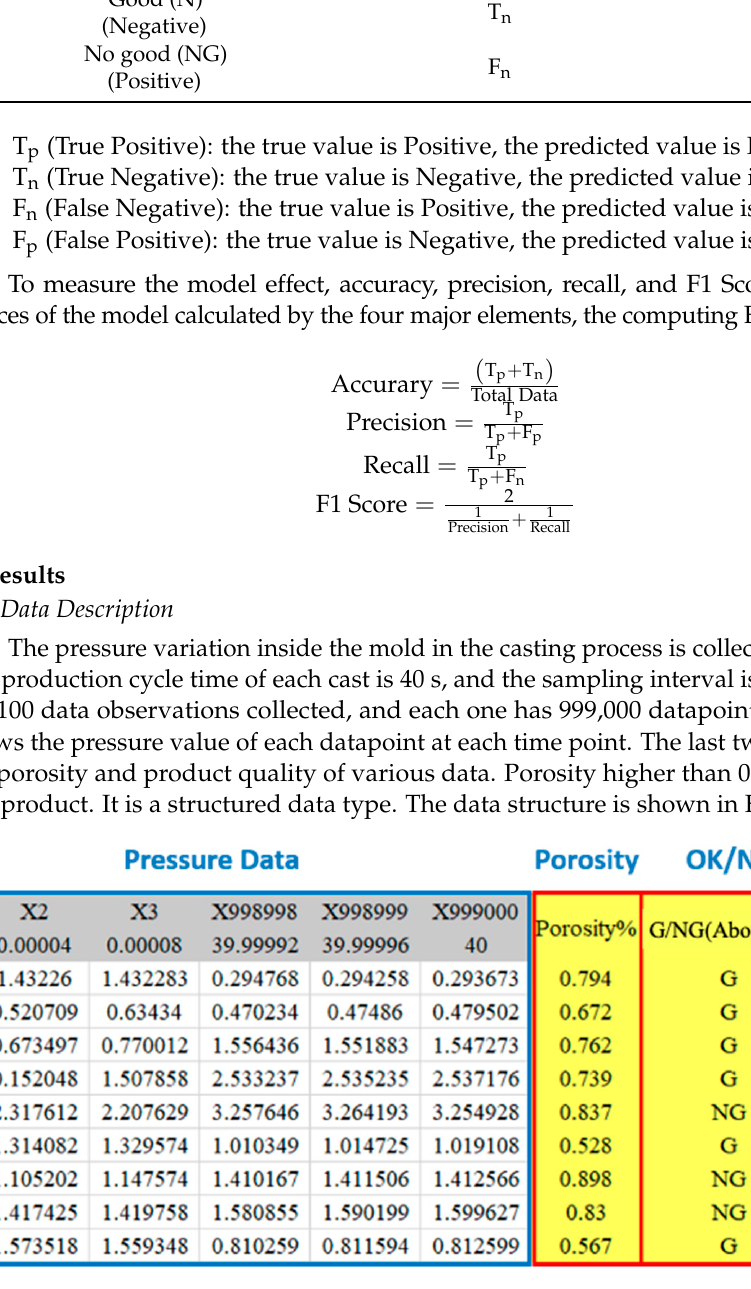
Figure 10. Press casting data structure.